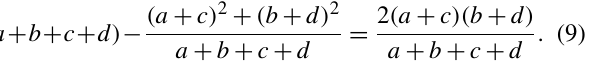
Table 3. Best possible score relative to Table 2’s data on occurrence.